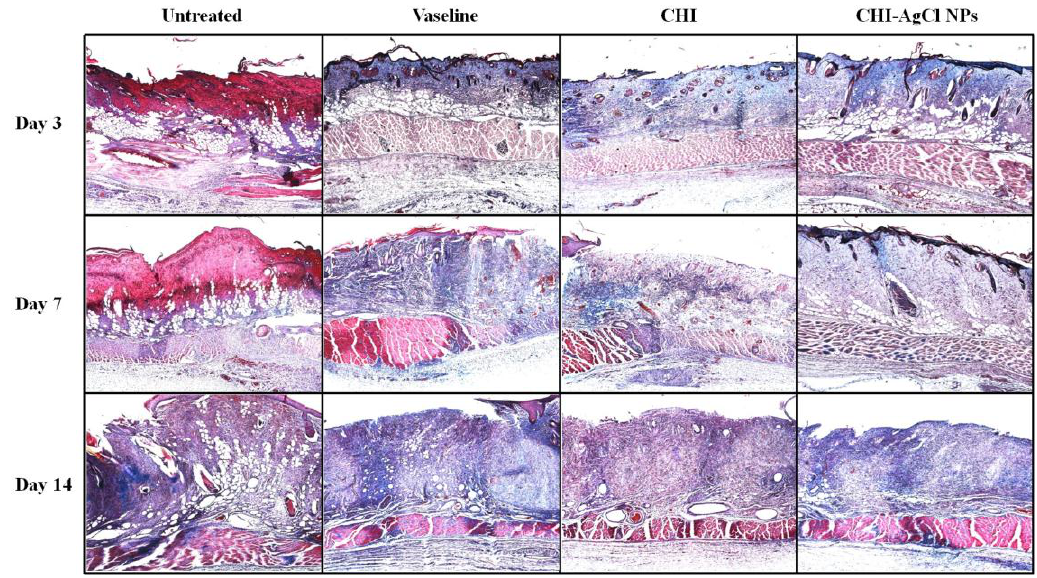
Figure 4. Evaluation of histopathology in the healing effect of ointment on burn induced skin damage using the Masson’s trichrome staining. The photographs were taken at an original magnification of ×40.